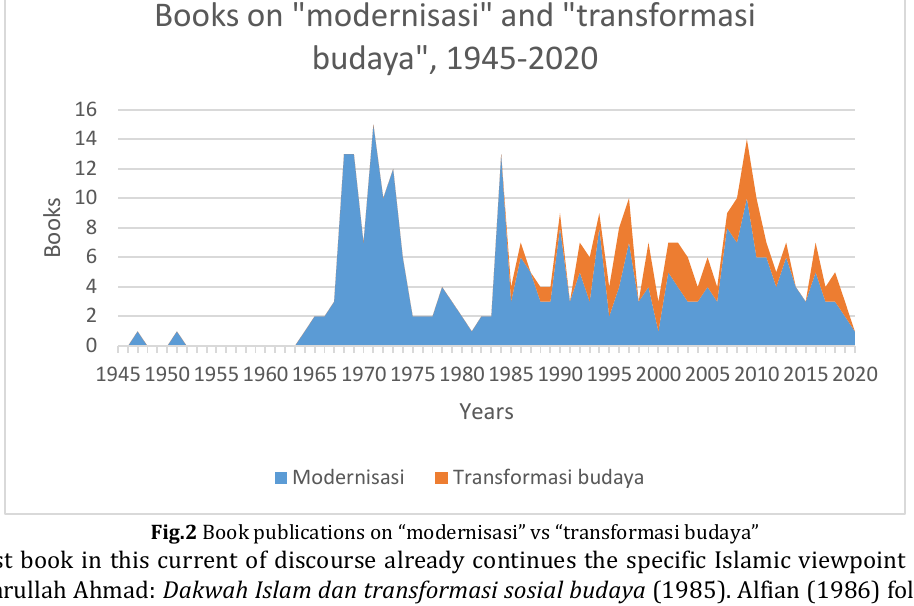
Fig.2 Book p ublications on “modernisasi” vs “transformasi